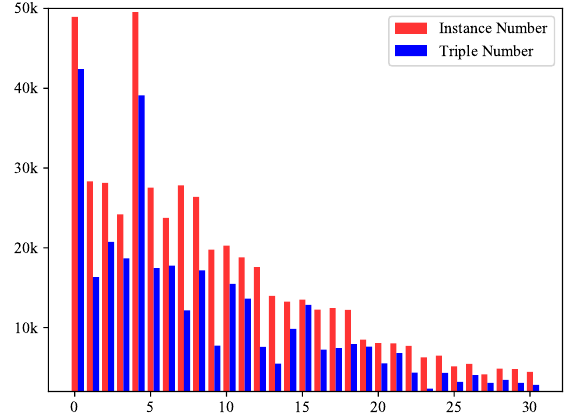
Figure 3. Instance/Triple Distribution in Baike dataset. The x-axis is the index of relations. The y-axis is the number of instances or triples.